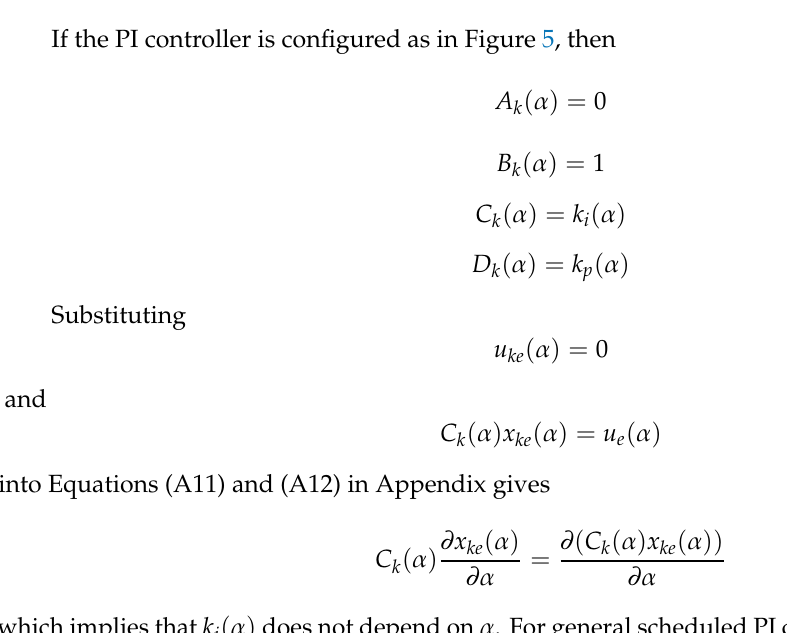
Figure 6. Step responses with a scheduled PI controller: case 1.